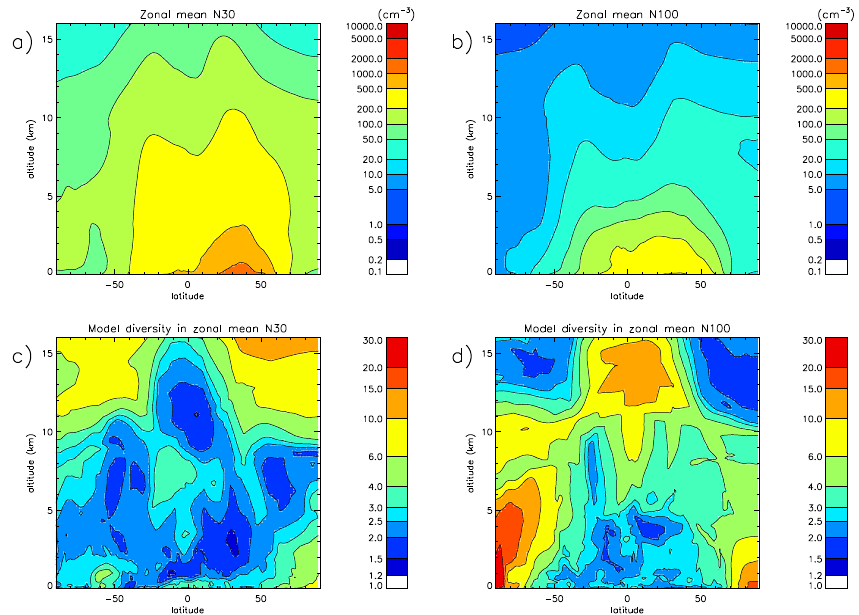
Figure 4. Zonal-mean vs. latitude and altitude plots of central-8 model mean and diversity for simulated annual mean size-resolved number concentrations for N(D p > 30nm) (a, c) and N(D p > 100nm) (b, d) . Diversity here is the ratio of the maximum and minimum values over the central 8 of the 12 models (defined locally, as described in Sect. 2.4). All concentrations are with respect to local temperatures and pressures in the models. Note that the geometric mean is used when averaging over the central-8